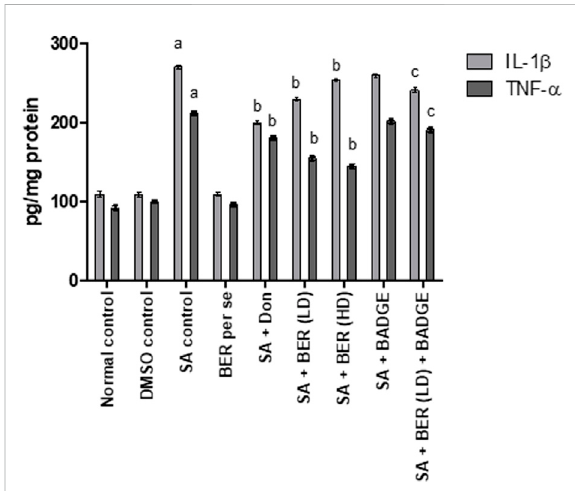
FIGURE 7 Impact of bergeninon brain cytokine levels (TNF- α and IL-1 β ) (pg/mg of protein). “ DMSO, dimethyl sulfoxide; SA, sodium azide; Don, donepezil; BER, bergenin; BER (LD), bergenin low dose; BER (HD), bergenin high dose; BADGE, Bisphenol A diglycidyl ether ” (Mehra et al., 2015). “ Each group ( n = 6) represents mean ± S.E.M, a = p ˂ 0.05 vs. normal control, b = p ˂ 0.05 vs. normal control, c = p ˂ 0.05 vs. SA control. One-way ANOVA followed by Bonferroni ’ s multiple range test ” .